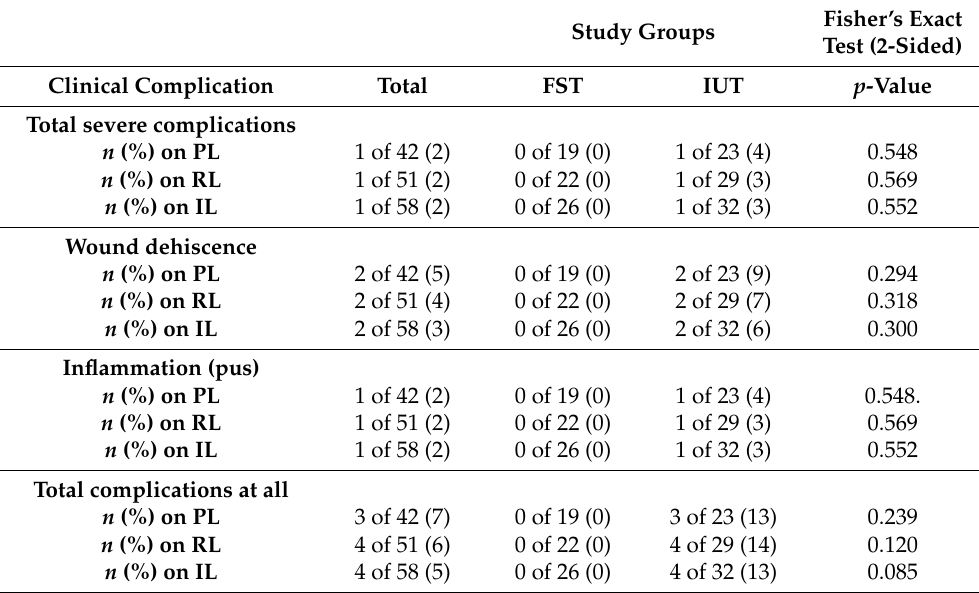
Table 2. Clinical complications at the patient, region, and implant